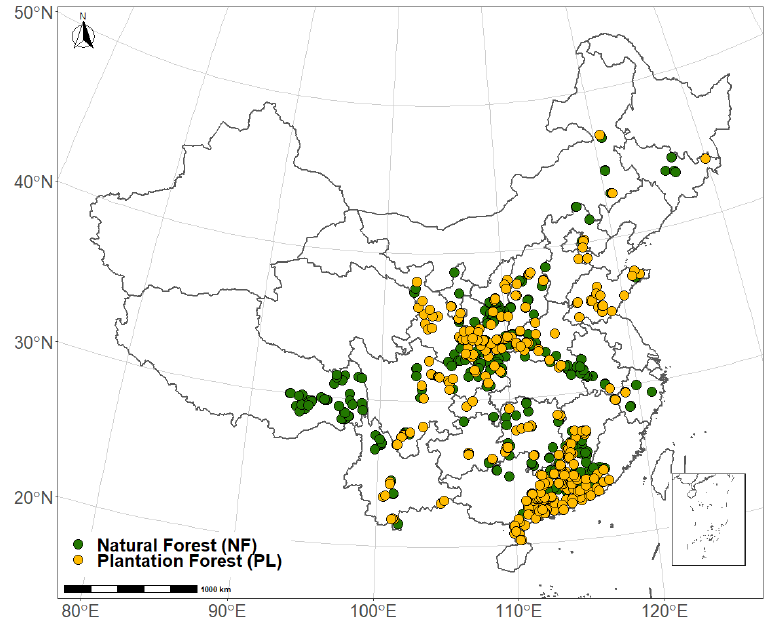
Figure 1. Sampling locations of the natural forests and plantations in this study.